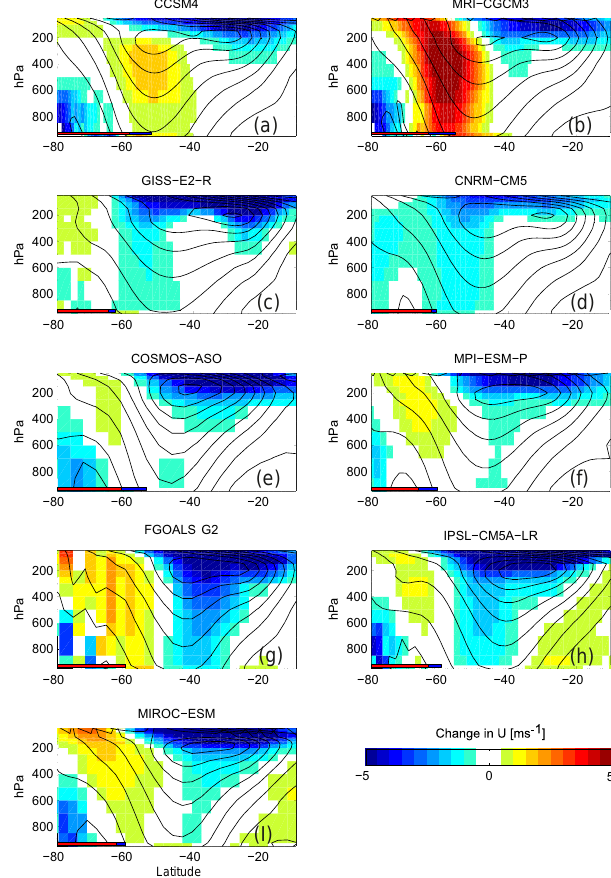
Figure 5. Change is the zonal mean wind velocity component in the westerly direction U (LGM − PI) throughout the atmosphere (shaded). Black contours show mean U for the PI. Red and blue bars at the bottom left of each panel indicate the extent of the zonal mean sea ice for the PI and LGM, respectively. Individual panels are labelled to indicate individual models. All values are annual